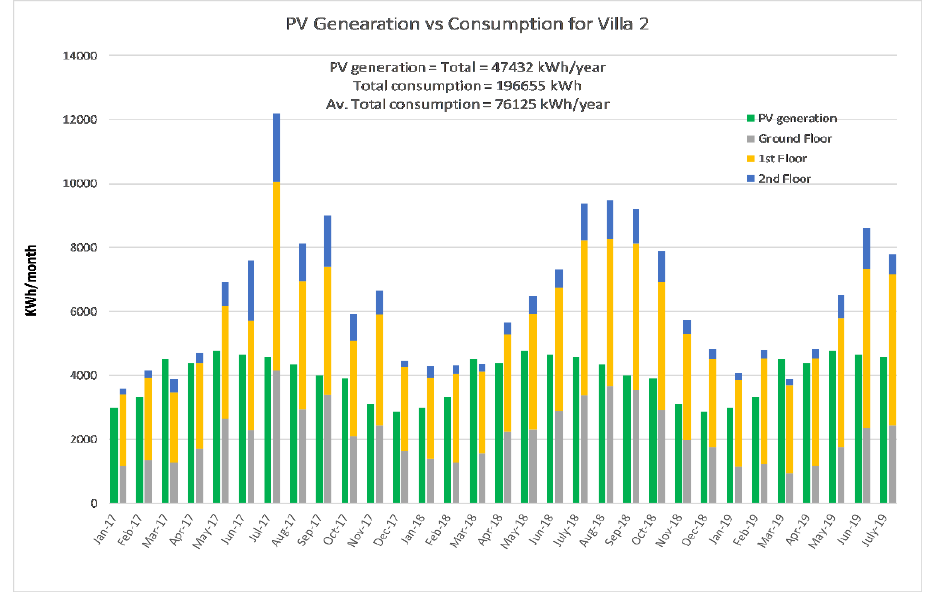
Figure 26. PV electricity generation vs consumption for Villa 2 for 31 months, from January 2017 until July 2019.